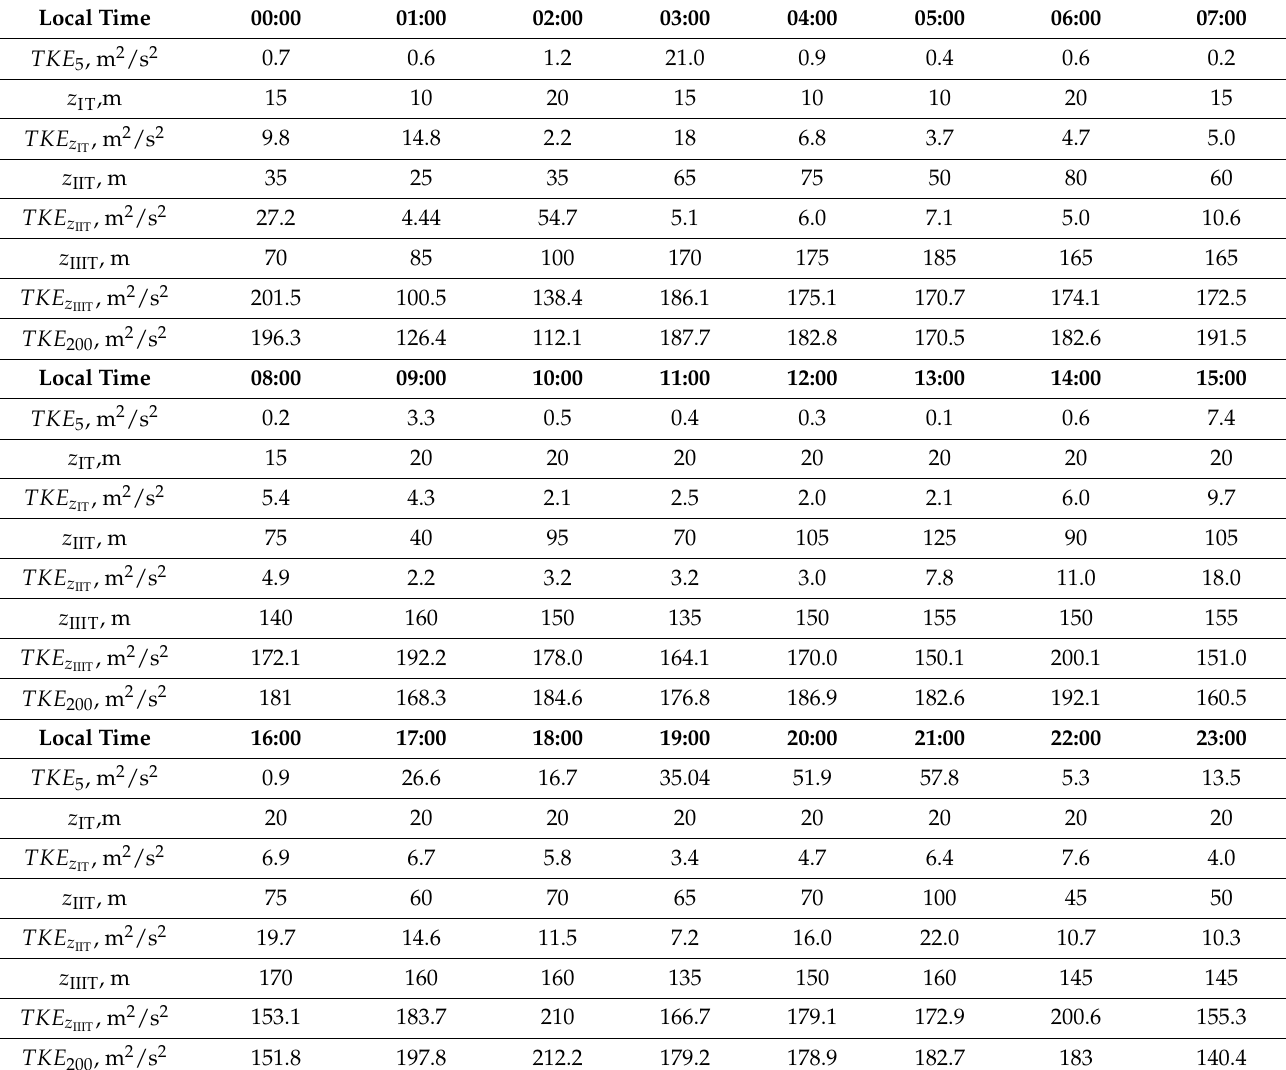
Table 1. Diurnal hourly variations of the altitudes of the three upper layer boundaries and the TKE values at these altitudes. Local Time